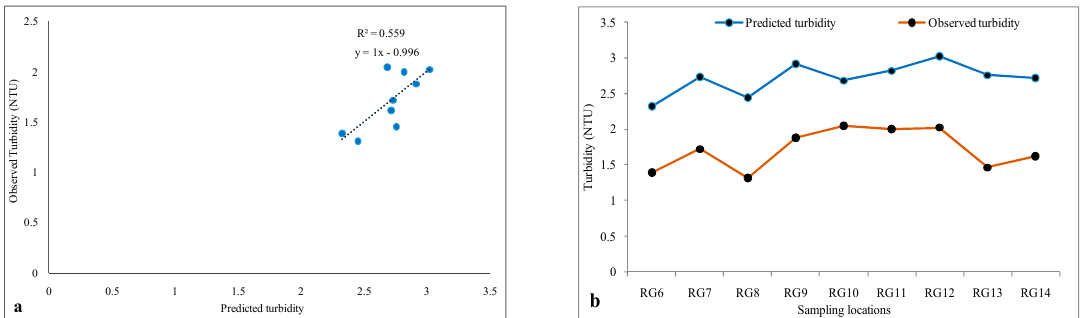
Figure 6. ( a ) Scatter plots and ( b ) line graphs show the comparison of observed and satellite-retrieved turbidity values at nine sampling sites from theRamganga River in March 2014.